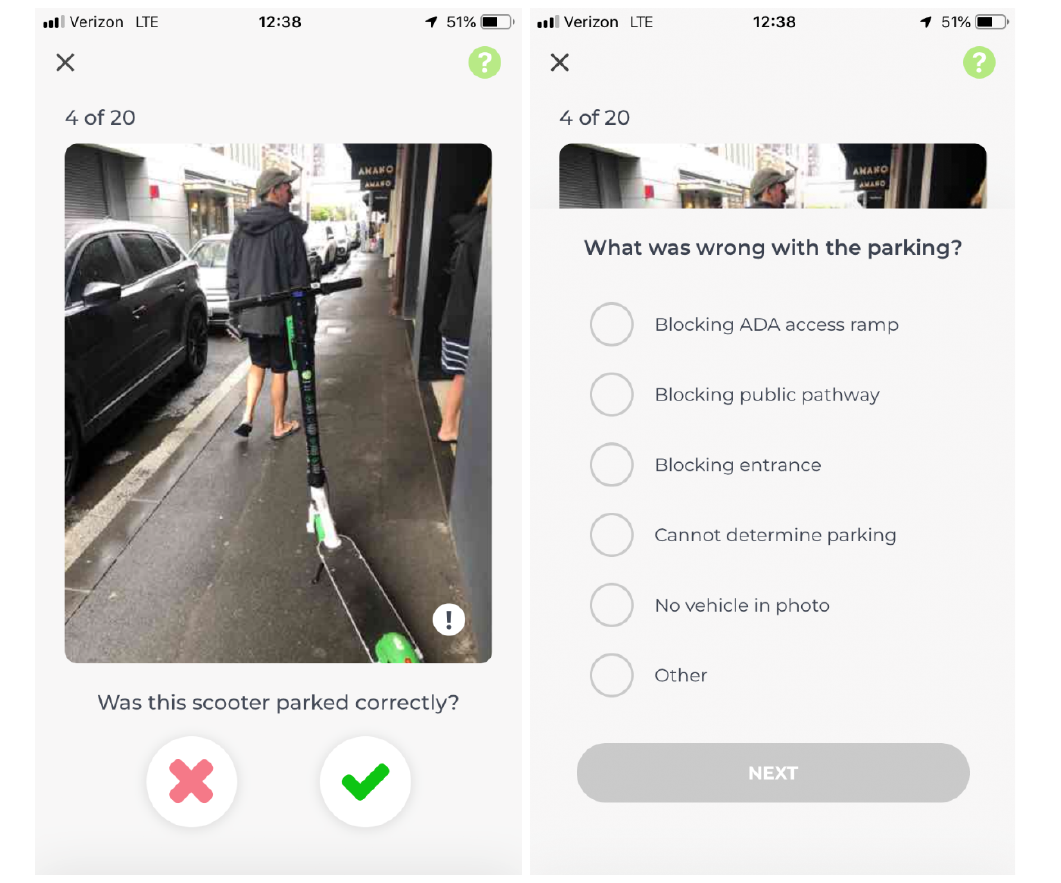
Figure 5. Screenshots of Lime’s Parked or Not feature. Source: Author. an active role in educating” other riders (Lime,